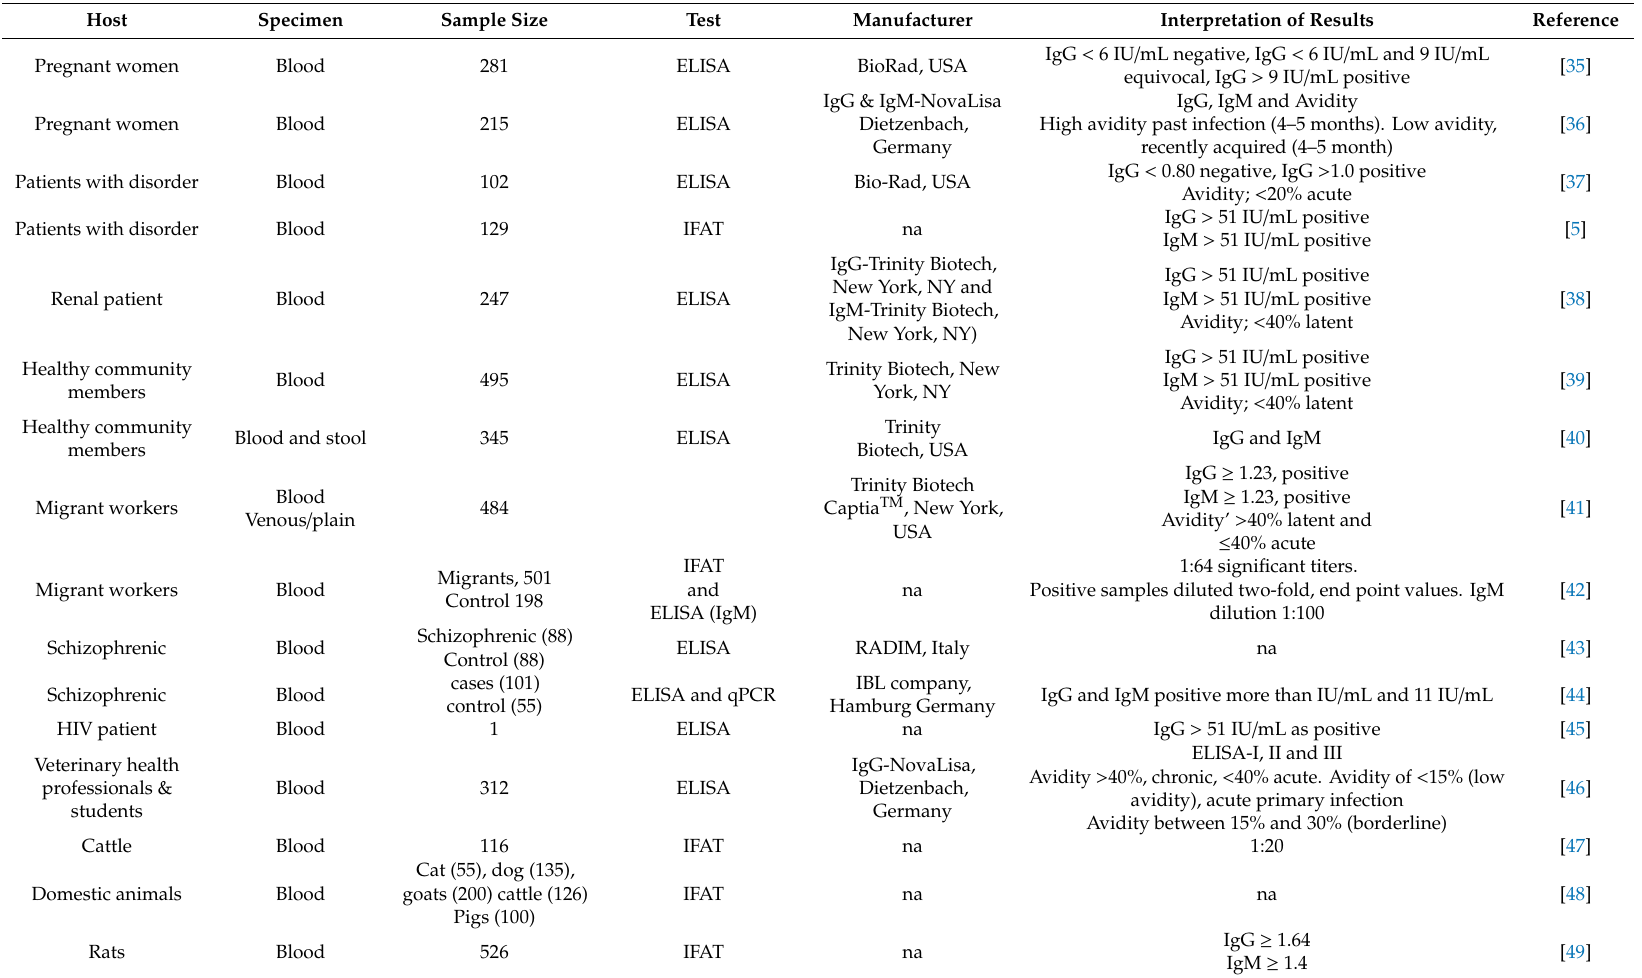
Table 1. Serological methods used for the detection of T. gondii antibodies in humans and animals in